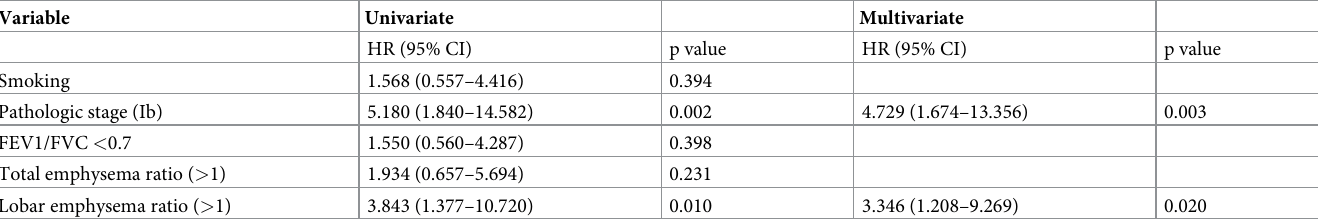
Table 4. Univariate and multivariate analysis of significant predictors for the overall survival in patients with stage I NSCLC.